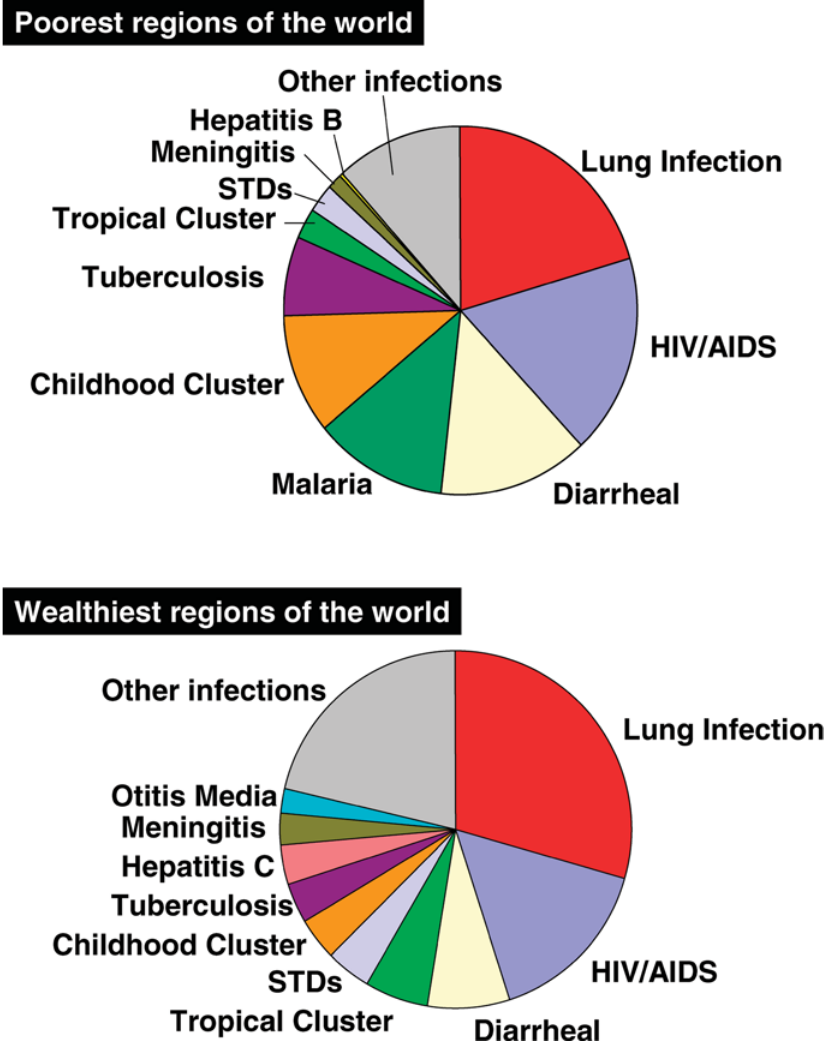
Figure 2. The Ten Leading Infections of the Poorest and Wealthiest Regions of the World These leading infections are represented as a fraction of the total infectious disease burden of that region, and are in clockwise descending order. (STDs, sexually transmitted deseases excluding